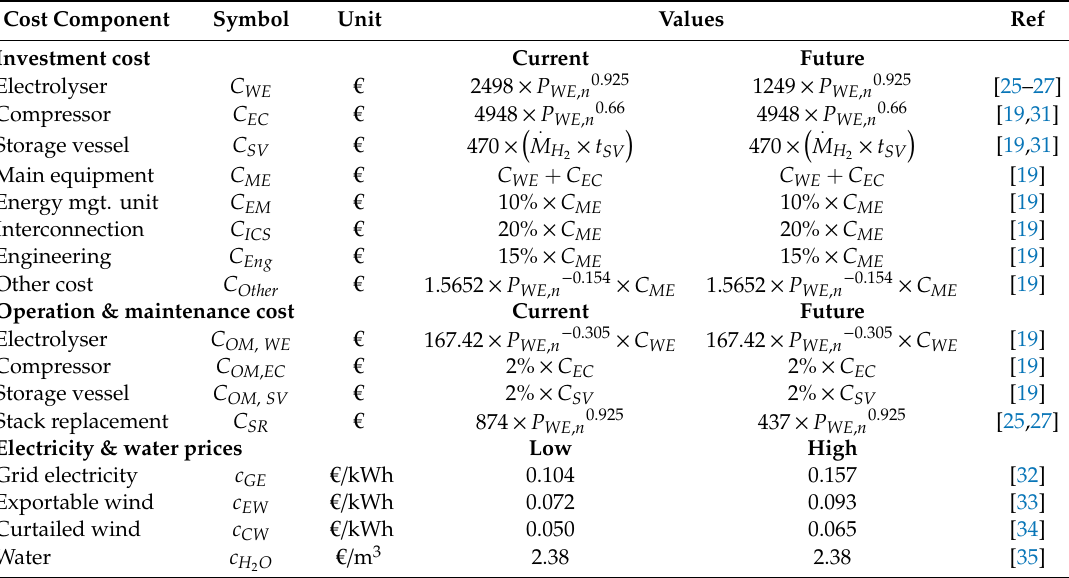
Table 1. Economic parameters in WHS, calculated using cost curve data from